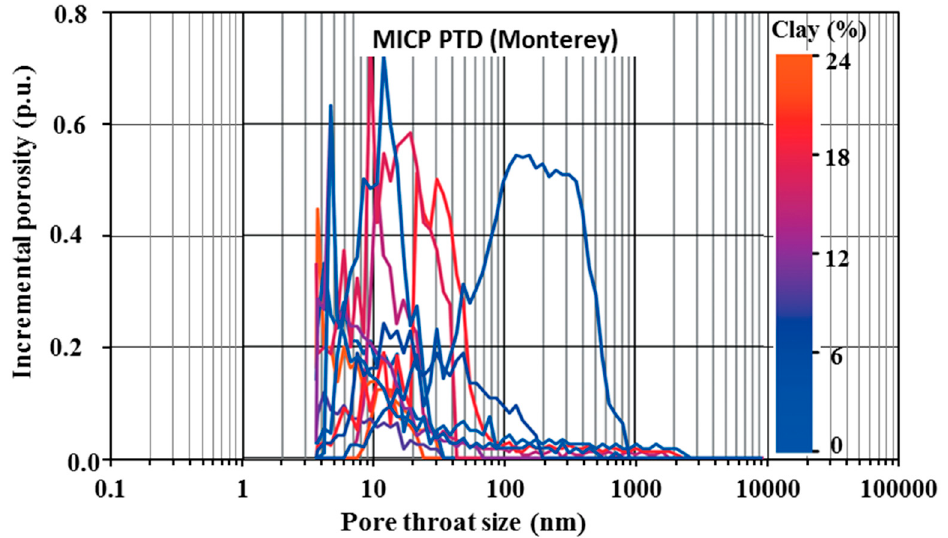
Figure 9. MICP pore throat size distribution (PTD) for Monterey shales. Modified from Saidian, Kuila [44].